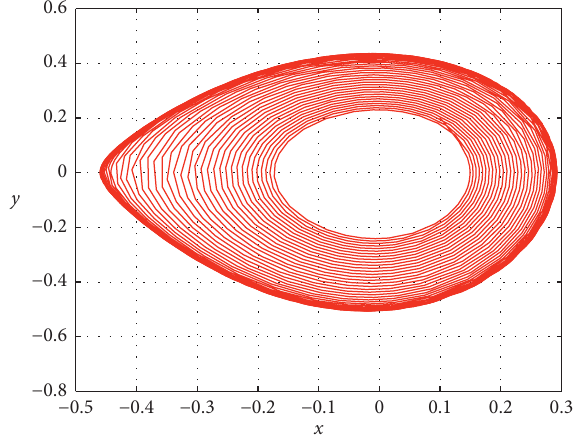
, μ ) � (− 0 . 001 , 1 2 , y ) � ( 0 . 1 , 0 . 2 ) . 0 0